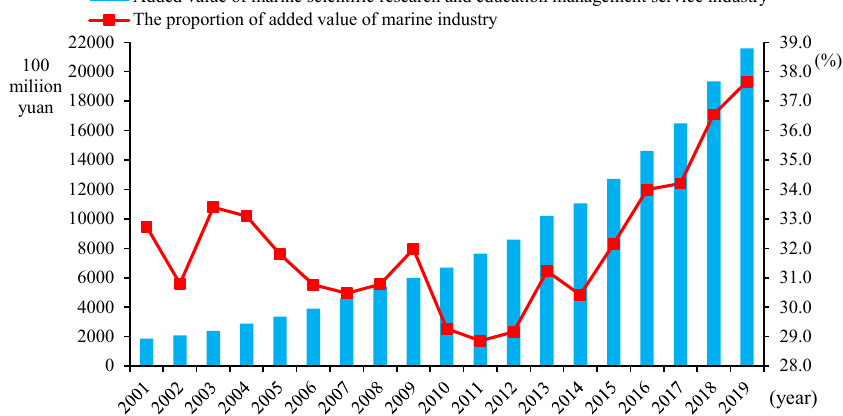
Figure 3. Development of